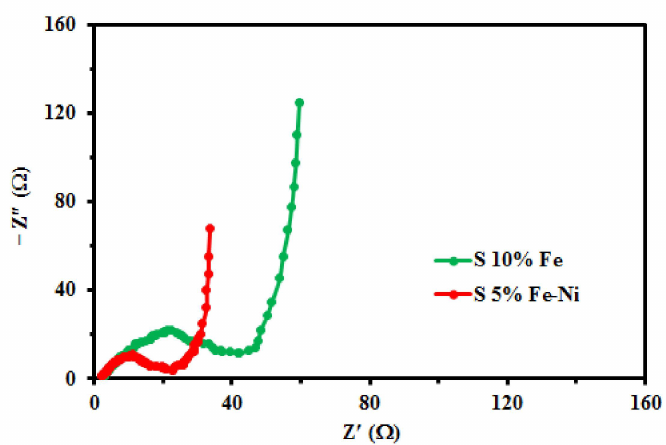
Figure 7. The Nyquist plots of the S5% Fe-Ni and S10% Fe samples.